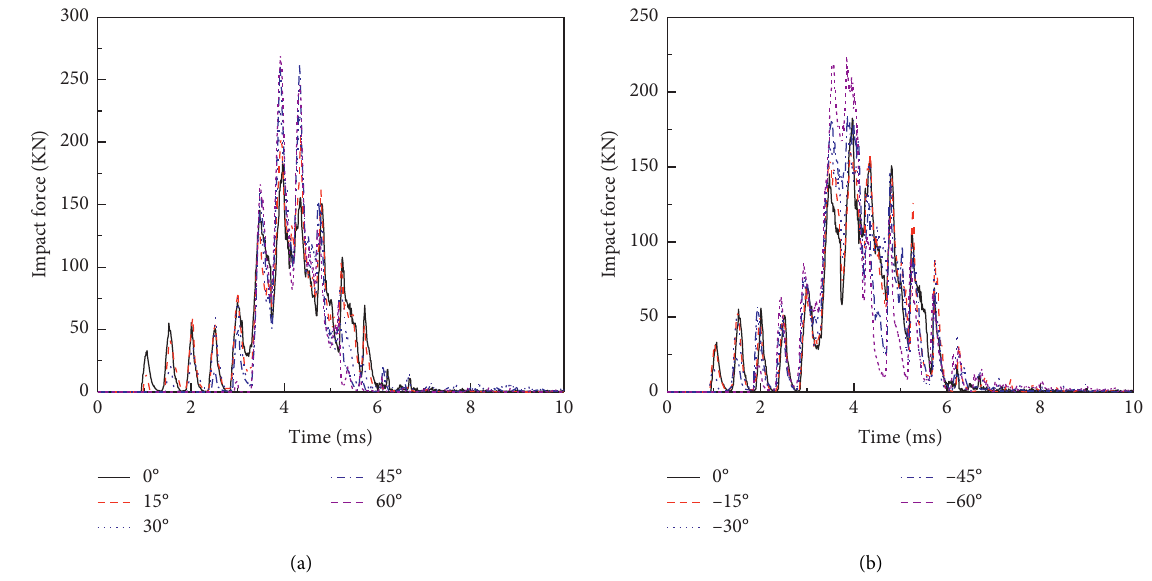
Figure 14: Pitch angle effect on impact loading history. (a) Positive pitch angle β . (b) Negative pitch angle β .